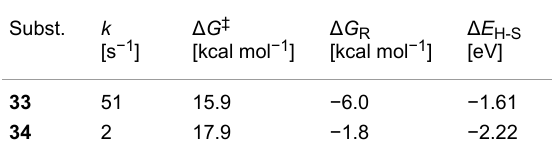
Table 7: Calculated kinetic and thermodynamic data (on the PW6B95- D3/QZVP//TPSS-D3/def2-TZVP level) and HOMO–SOMO gap Δ E H-S (on the TPSS-D3/TZVP level) of the reactions of 33 and 34 in benzene at 40 °C.